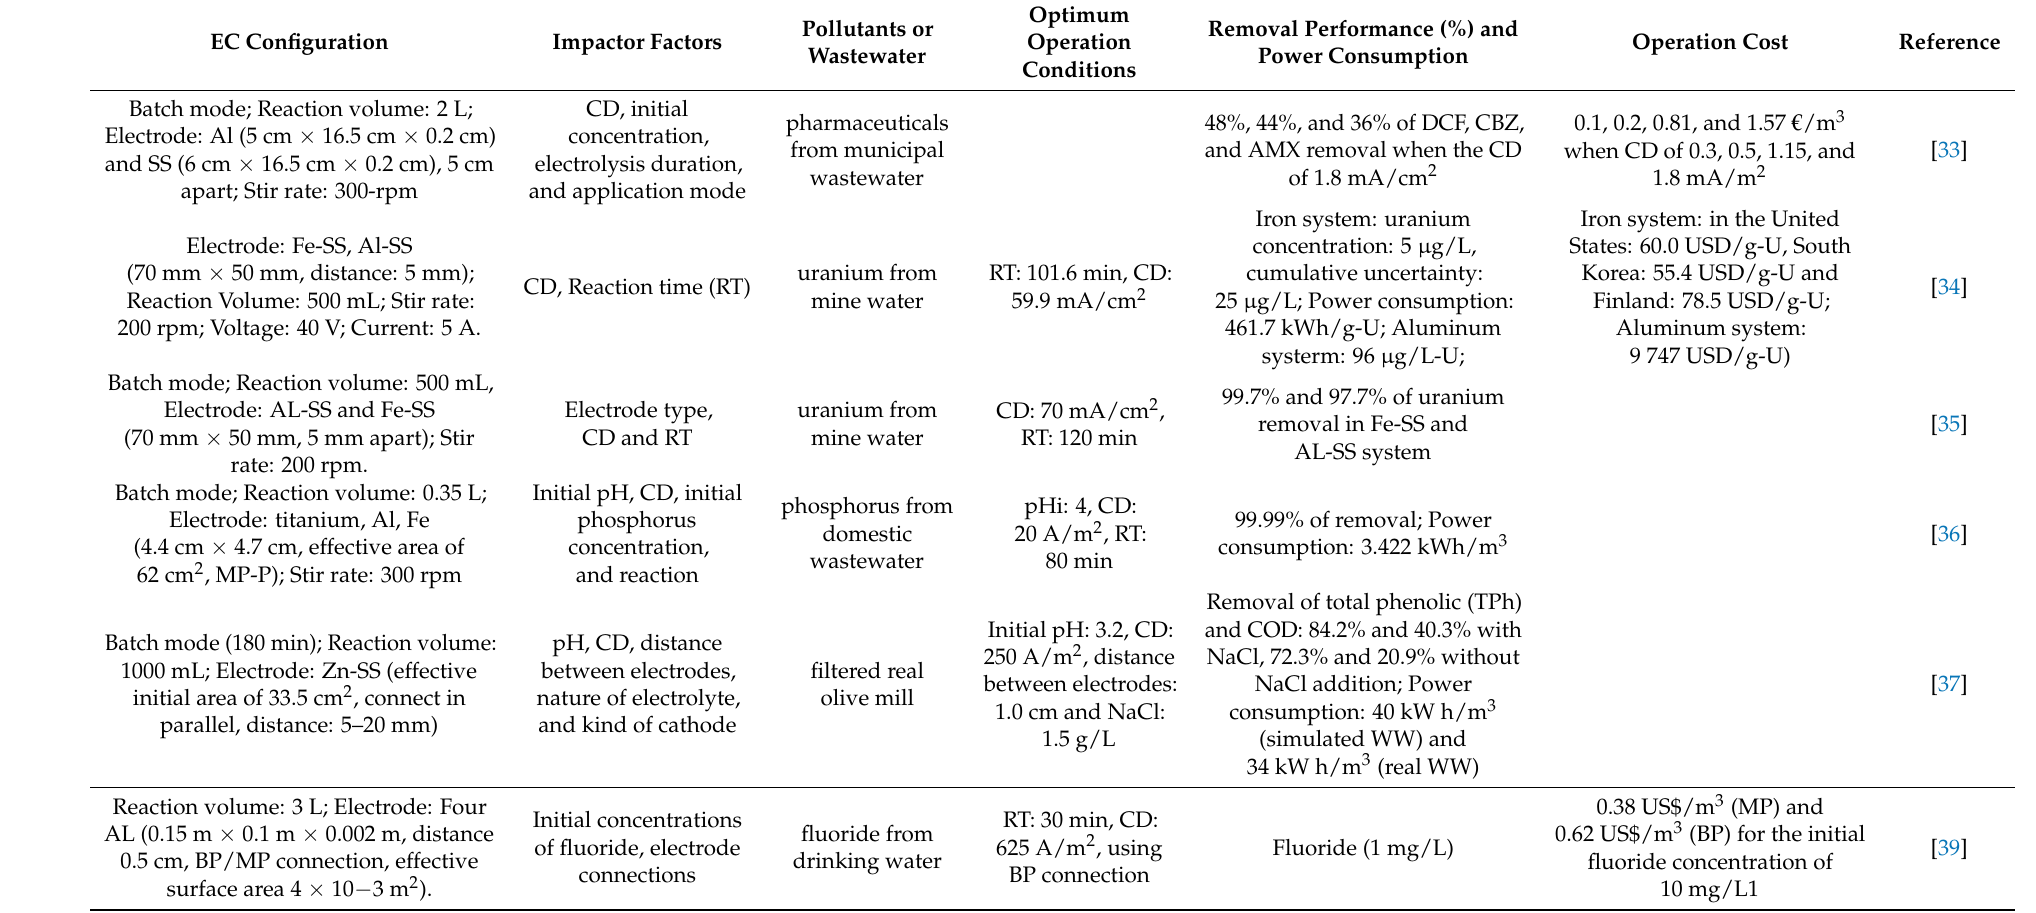
Table 2. Summary of the removal efficiencies, power consumption, and operation cost of EC processes under different operating conditions.